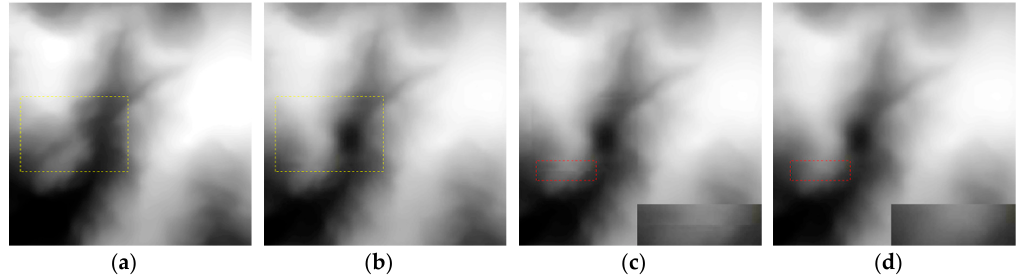
Figure 10. Marginal effects of repair results. ( a ) The column is the original DEM data; ( b ) the column is the DEM data after filling; ( c ) the column is marginalization effect; and ( d ) the column is the elimination of marginalization. (The data before and after repair are shown in the yellow box, and the data before and after the marginalization effect are smoothed in the red box).